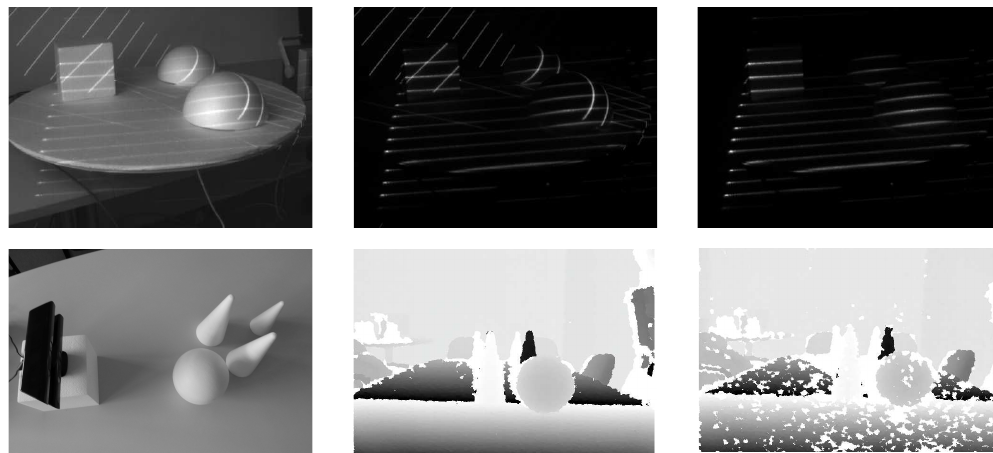
Figure 9. An illustrative example of the behavior of the developed acquisition procedure when two identical sensors are directed at the same scene and a comparison with a commercial sensor. Upper row: a sample scene illuminated with two ATRIS sensors ( left ); the demodulated images with non-cyclic orthogonal codes ( middle ); the demodulated images with cyclic orthogonal codes ( right ). Lower row: acquisition setup with two Kinect (v1) sensors ( left ); captured depth image when one sensor is active ( middle ); captured depth image when both sensors are active ( right ). Observe how the ATRIS sensor is able to compensate for the mutual interference, to recover a spatial distortion map and is unaffected by the pattern projected by the second ATRIS sensor.